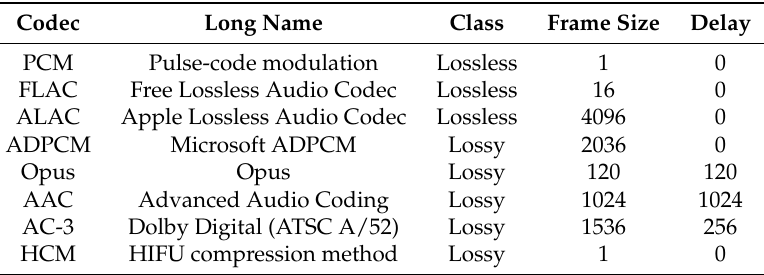
Table 2. Overview of tested formats and codec